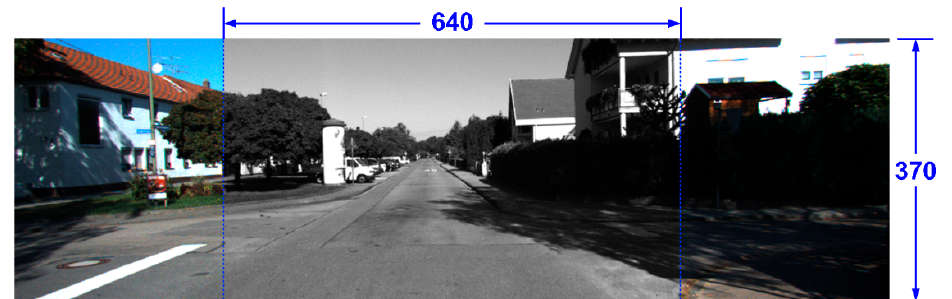
Figure 25. Image tailored from KITTI dataset.